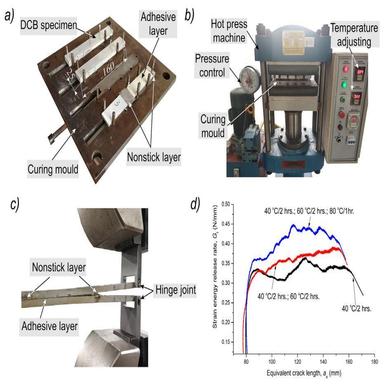
DCB specimen manufacture and testing: a) Assembling process of DCB specimen in mould, b). Hot curing process, c) Mode-I loading, d) Experimental Rcurves.